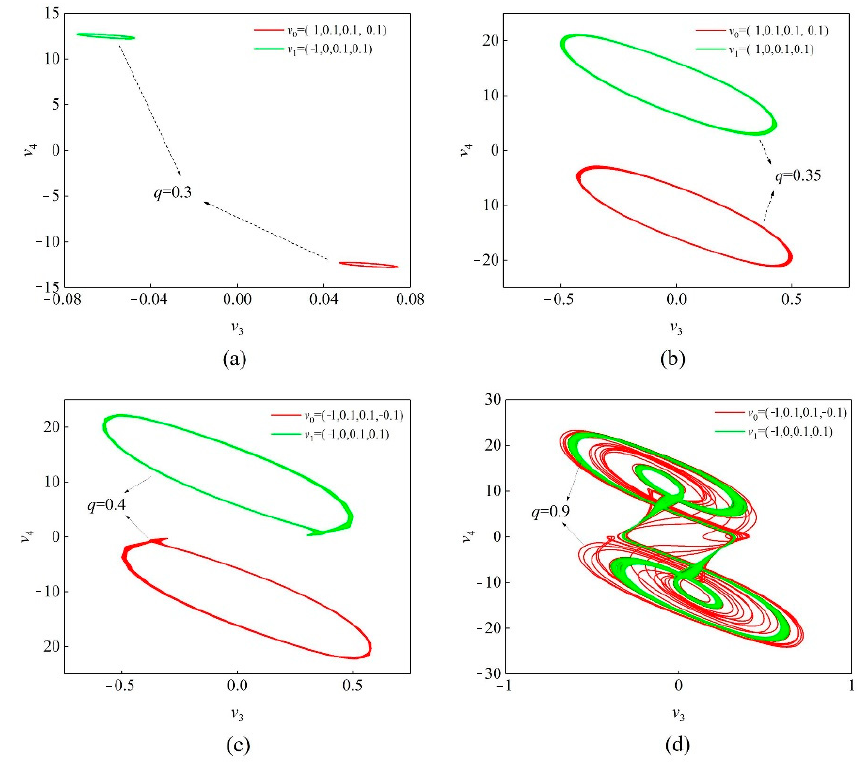
Figure 9. Attractor coexistence on the v 3 - v 4 phase plane with ( a ) q = 0.3; ( b ) q = 0.35; ( c ) q = 0.4; ( d ) q = 0.9.